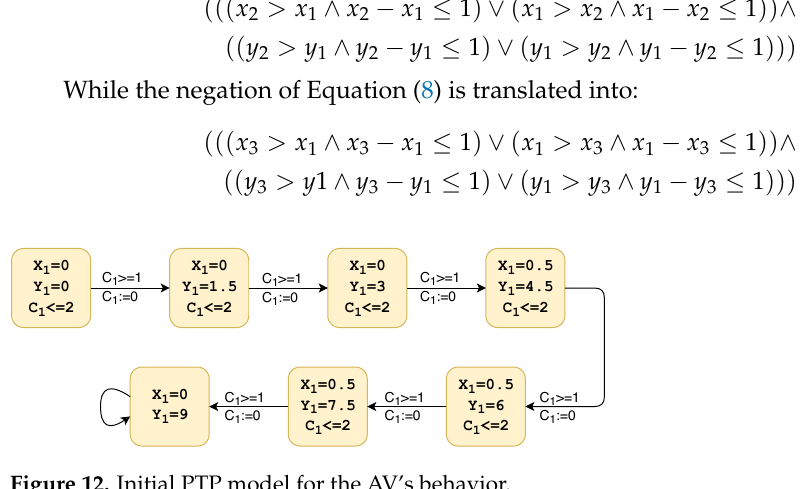
Figure 12. Initial PTP model for the AV’s behavior.